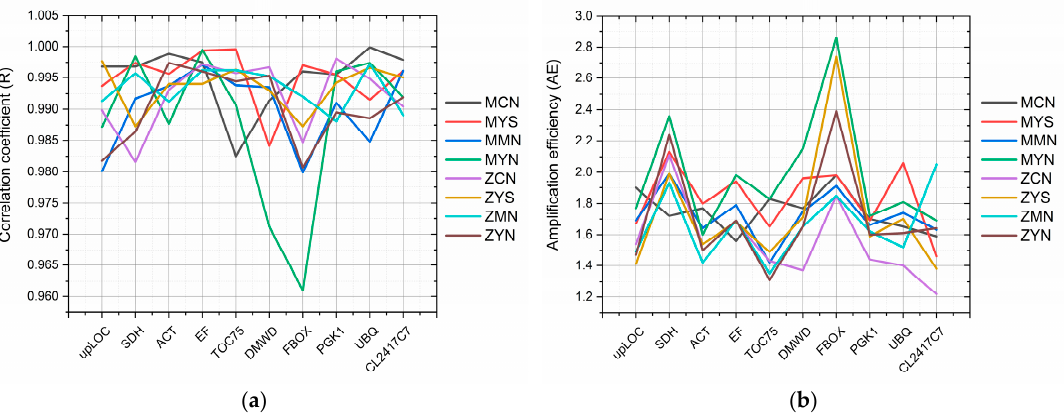
Figure 3. Correlation coefficient and amplification efficiency of ten candidate reference genes across all samples. ( a ) Correlation coefficient; ( b ) amplification efficiency. The legend on the right displays colored sample code information, see Table